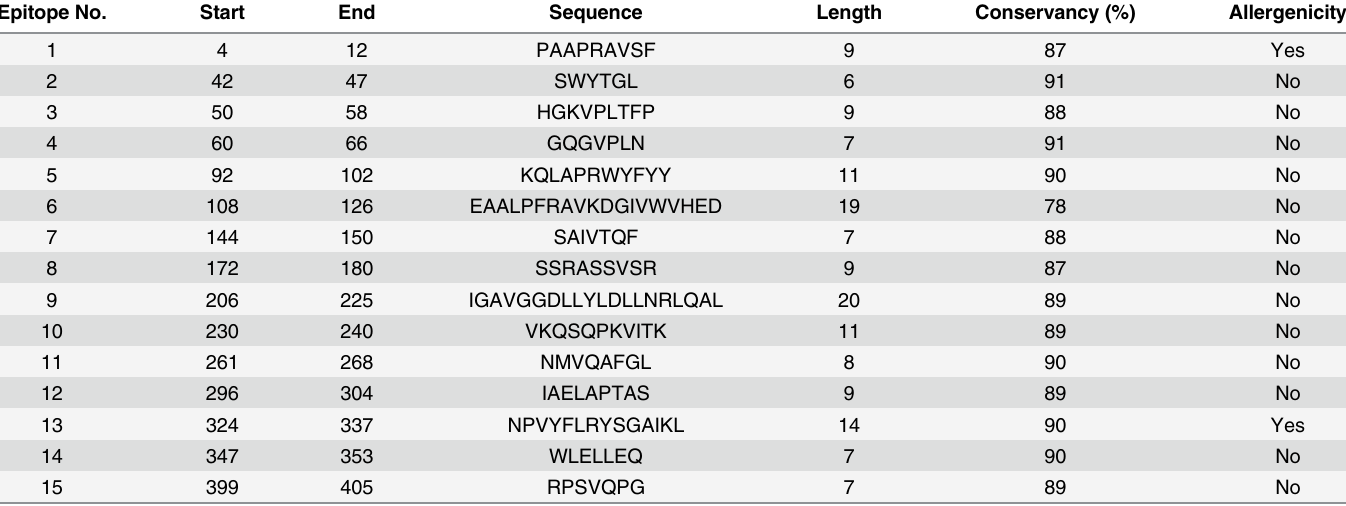
Table 2. Predicted linear B-cell epitopes of the N protein of MERS-CoV with their conservancy and allergenicity. Epitope